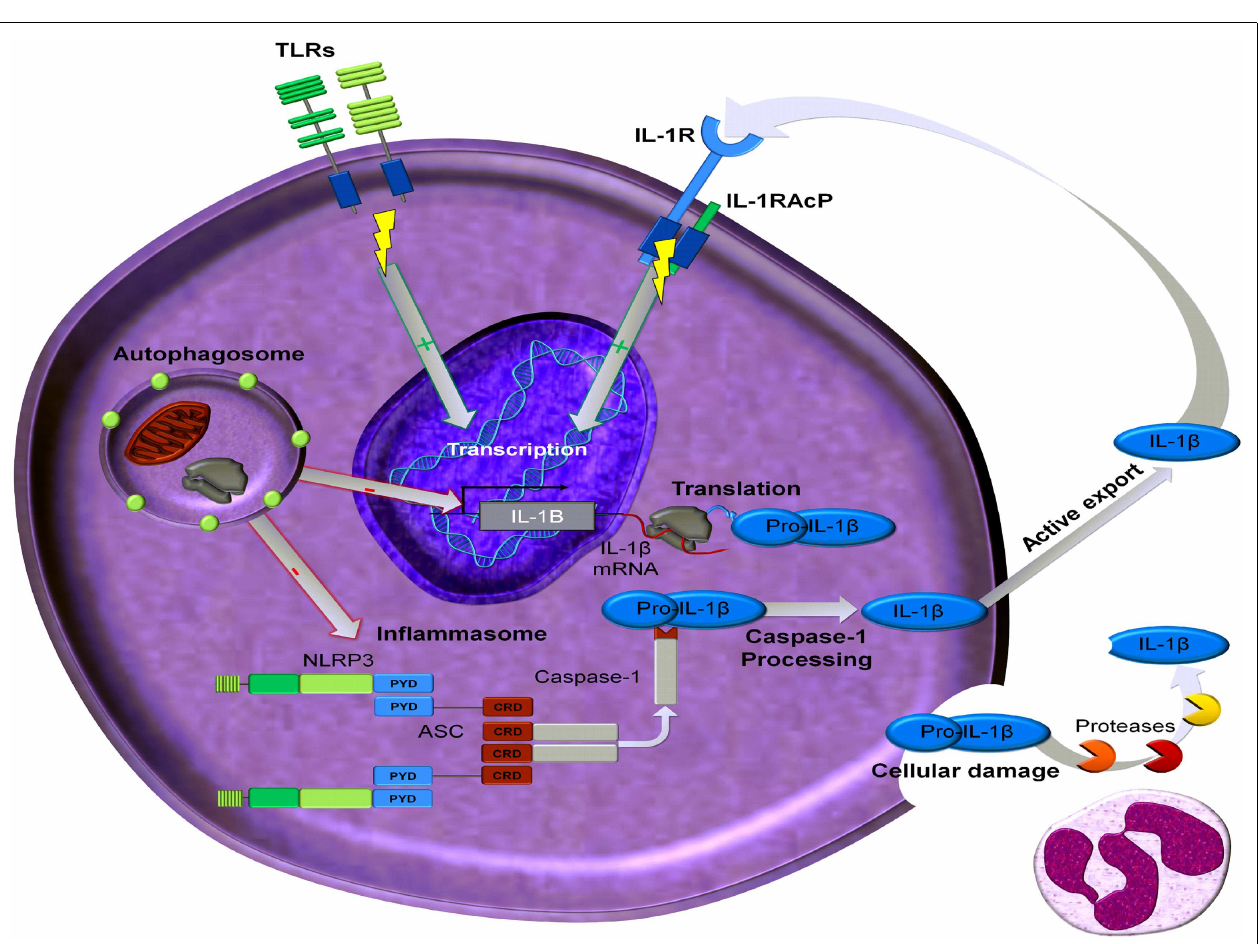
which is part of the inflammsome. In addition proteases, predominantly derived from neutrophils, can cleave extracellular pro-IL-1 β , which will be present extracellularly in the setting of damaged inflammatory cells.This processed mature and bioactive IL-1 β can then induce its own